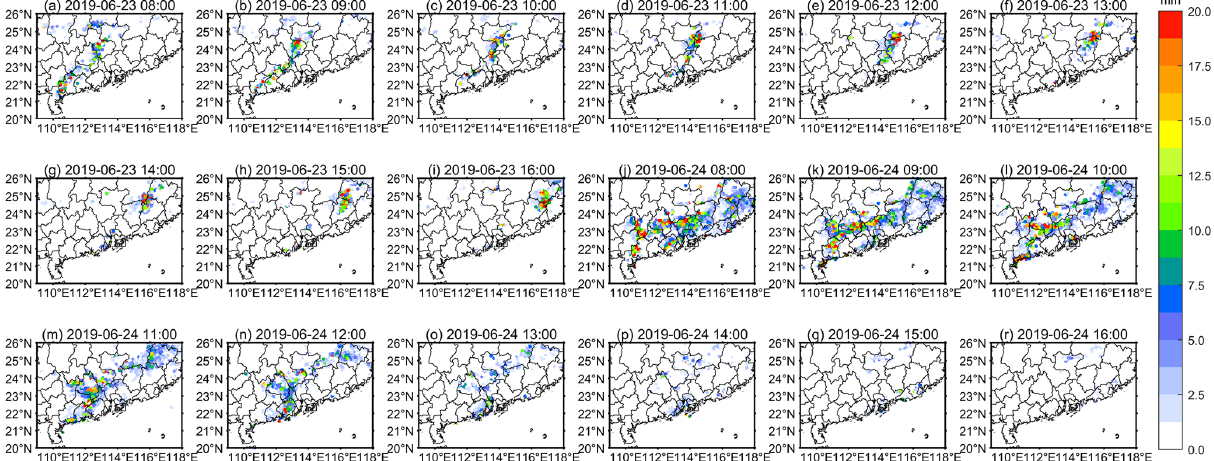
Figure 6. Actual precipitation based on high-density automatic stations at (a–i) 08:00–16:00CST on 23 June and (j–r) 08:00–16:00CST on 24